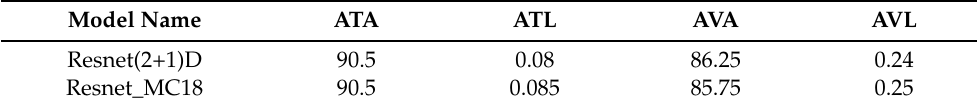
Table 8. General video classifier results.